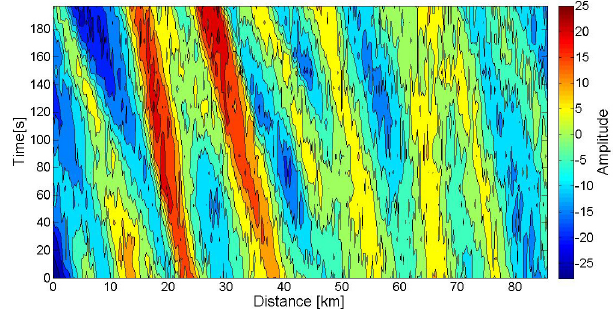
Figure 3. Hovmöller diagrams of the raw data along the propagation direction for consecutive time steps.